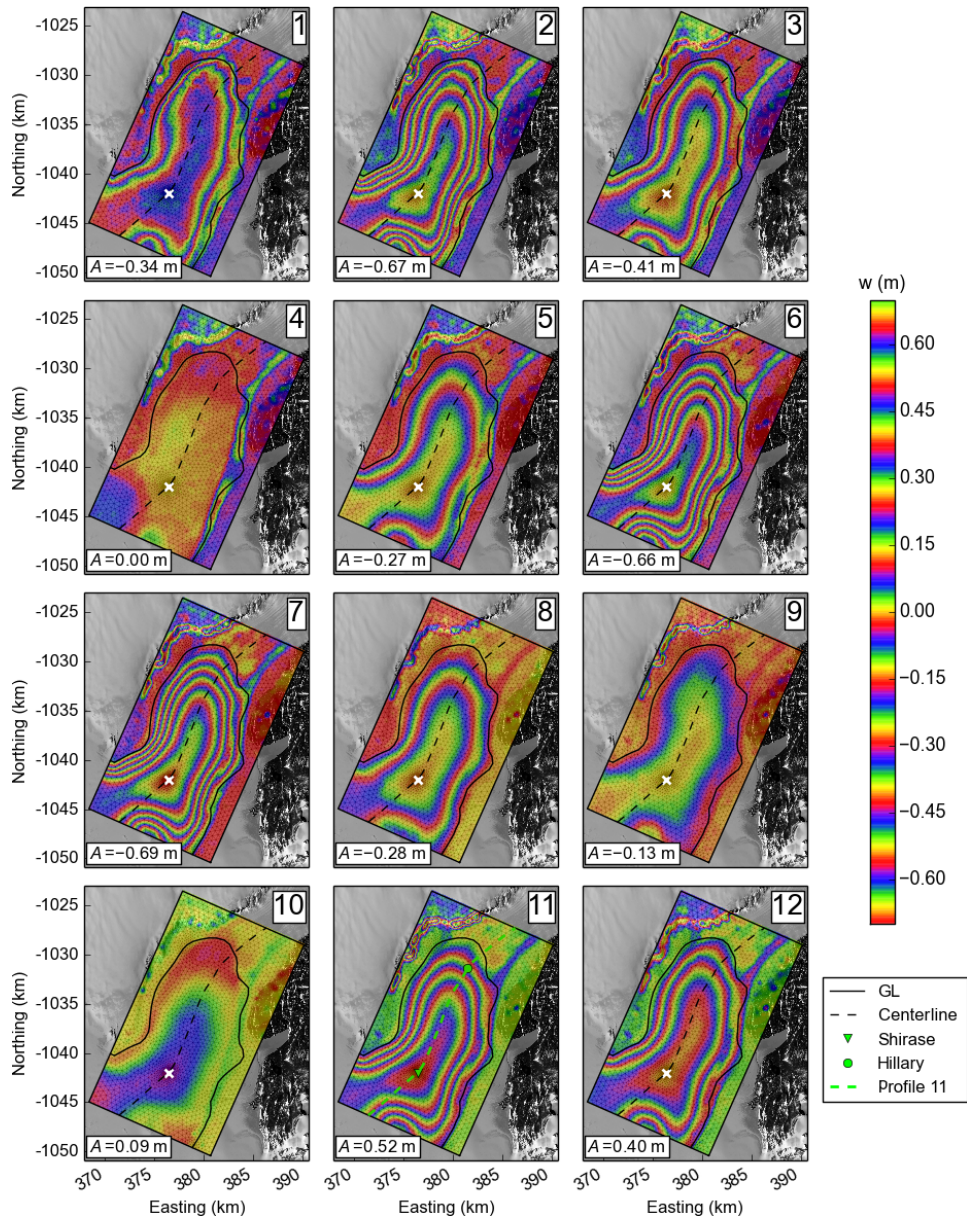
Figure 5. Reconstructed vertical displacement maps in the grounding zone of the Darwin Glacier. The images show surface displacement due to ocean tides at the 12 times of SAR data acquisition. Dashed black lines along the glacier’s centerline correspond to the profiles shown in Fig. 6. The white cross marks the tide-model location. The green triangle and dot in the lower centre panel mark the locations of the two GPS stations Shirase (freely floating) and Hillary (within the tidal-flexure zone). Finite-element mesh in grey; mean course of the grounding line as determined from 45 DInSAR images in black. Note the ice rise in the bottom left corner of every panel. The map background is contrast-stretched Landsat 8 panchromatic